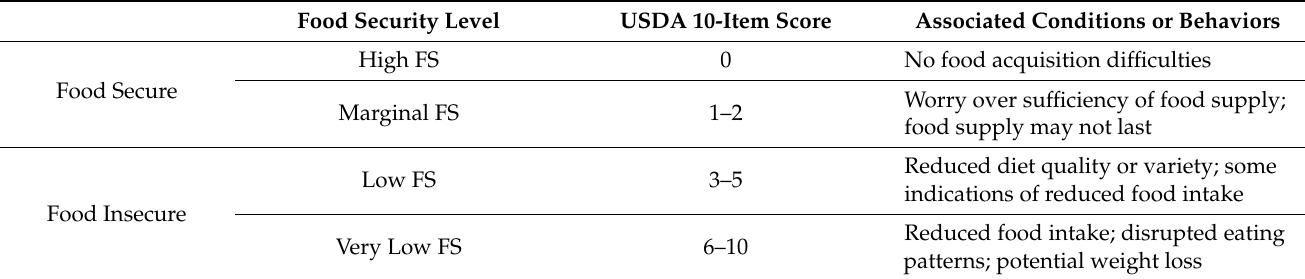
Table 1. Conditions associated with FS level according to the USDA 10-Item FS questionnaire. Food Security Level USDA 10-Item Score Associated Conditions or Behaviors High FS 0 No food acquisition difficulties Food Secure Marginal